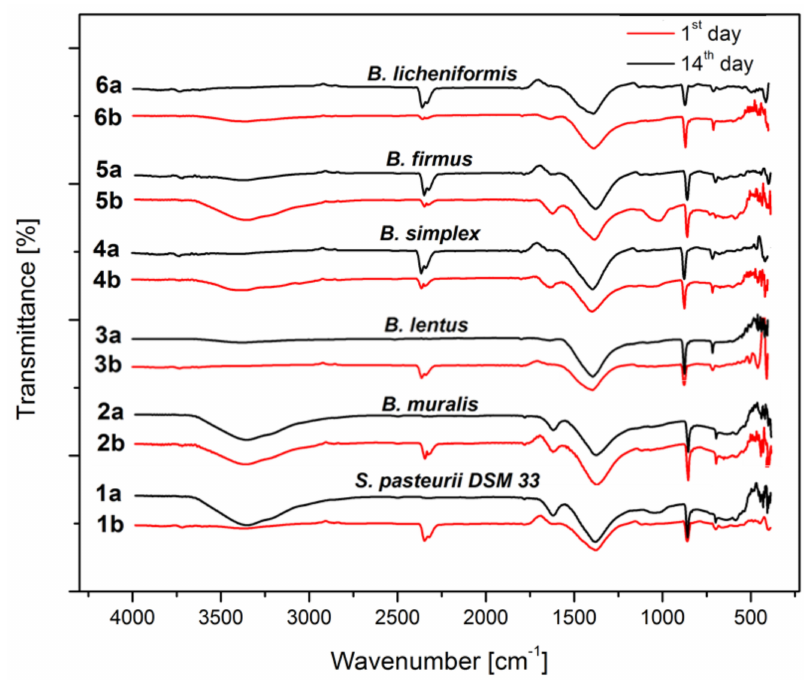
Figure 6. FTIR analysis (a—1st day; b—14th day; 1— S. pasteurii DSM 33; 2— B. muralis ; 3— B. lentus ; 4— B. simplex ; 5— B. firmus ; 6— B. licheniformis